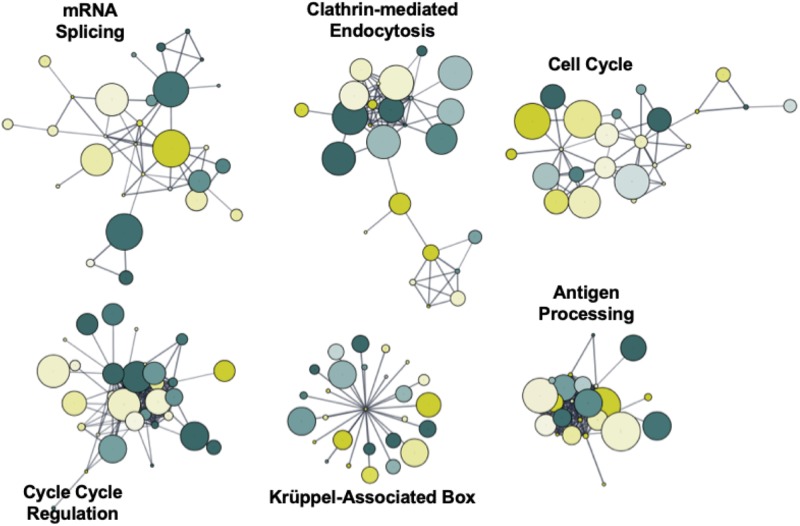
Functional network enrichment analysis. Weighted gene co-expression network analysis of DMRs based on protein-protein interactions found within the STRING database. Network topology was defined according to both the degree of interaction and number of common nodes (minimum of 3) using a Markov cluster algorithm (MCL).